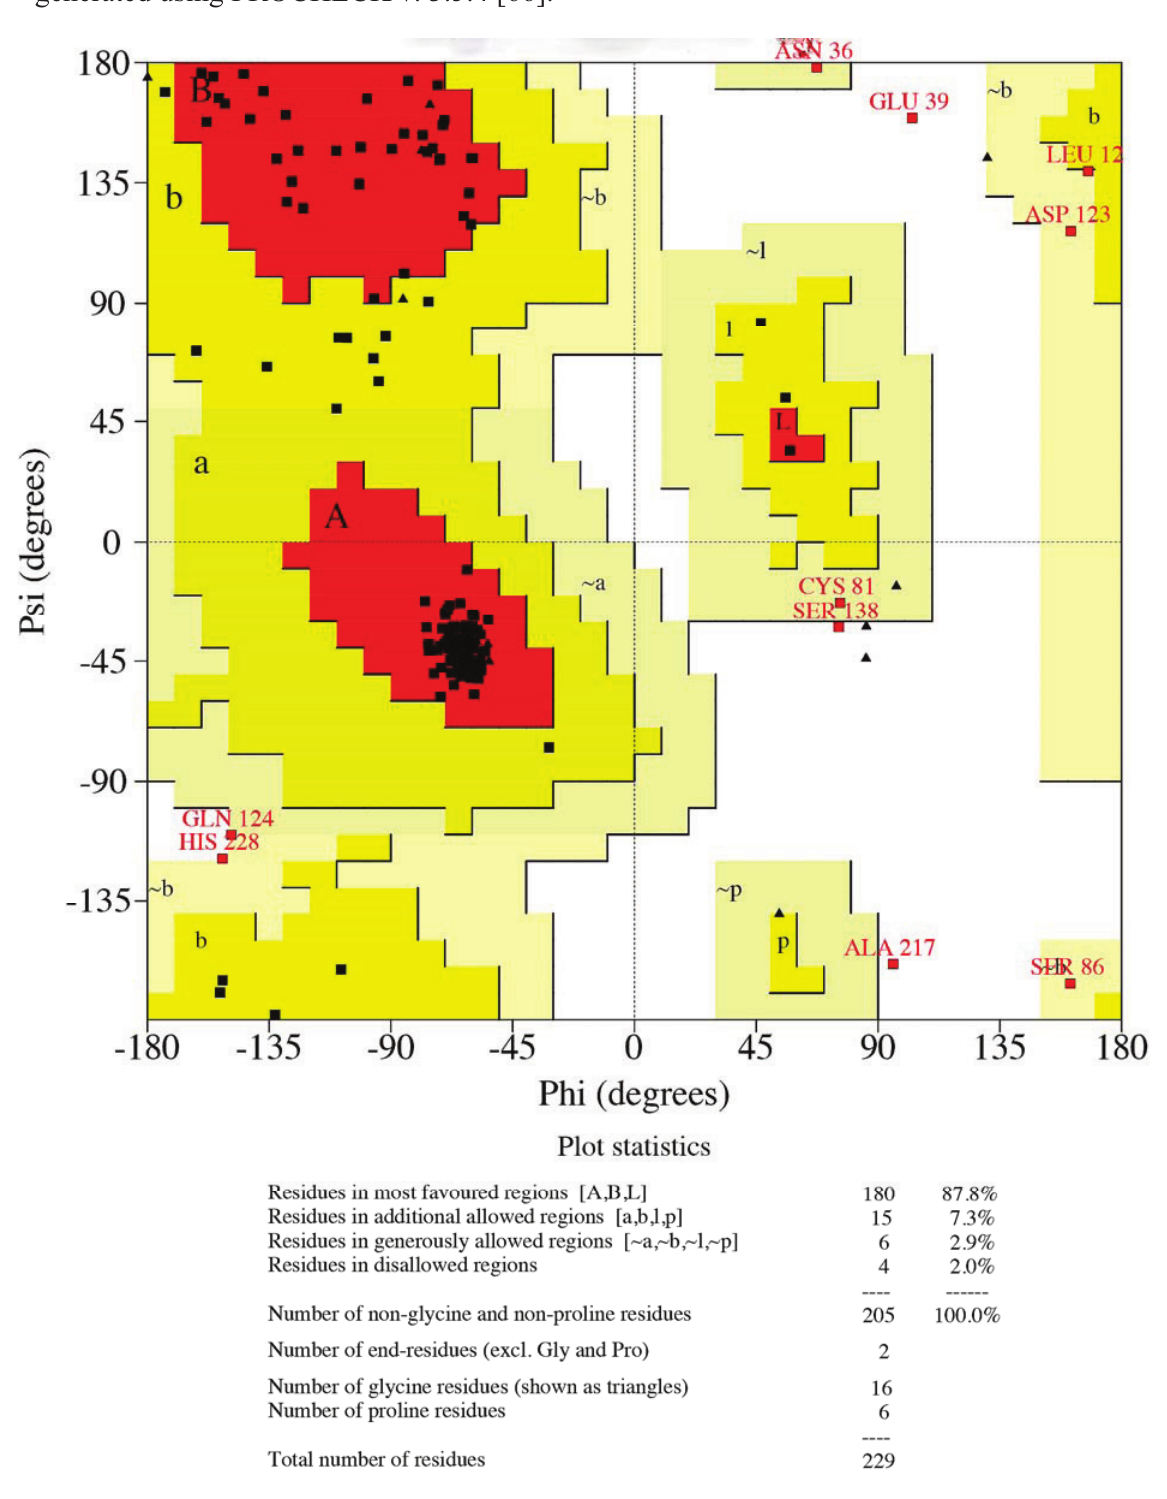
Figure 5. Ramachandran plots for GmTsp42Ed: The plot statistics are indicated for all the non-glycine and non-proline residues that fell within the favored regions. Shown in red, yellow, pale yellow, and white, respectively, are amino acid residues in most favored, additionally allowed, generously allowed, and disallowed regions. Based on the analysis of 118 structures of resolution of at least 2.0 Angstroms and R-factor no greater that 20%, a good model is expected to have (cid:5)90% in the most favored regions. The plots were generated using PROCHECK v. 3.5.4